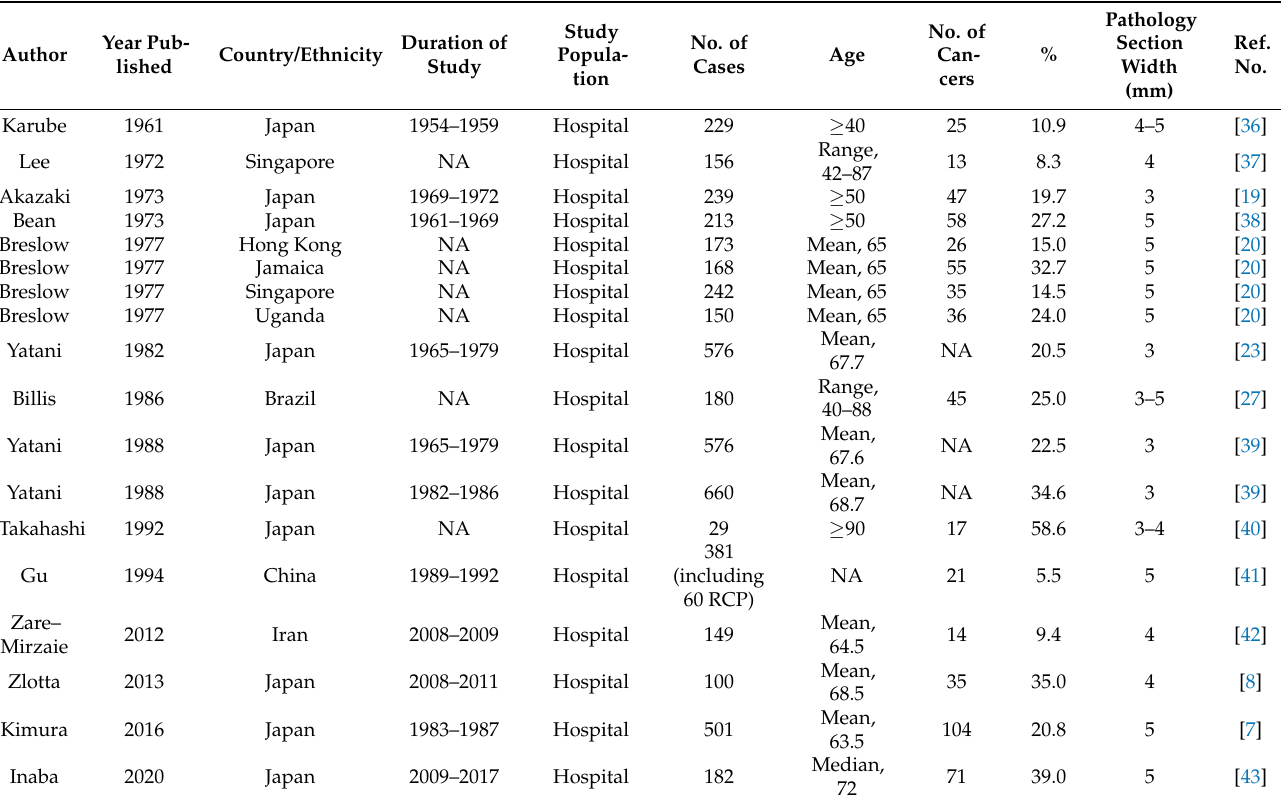
Table 2. Studies evaluating latent PC by step-sectioning of prostate in Asian and other